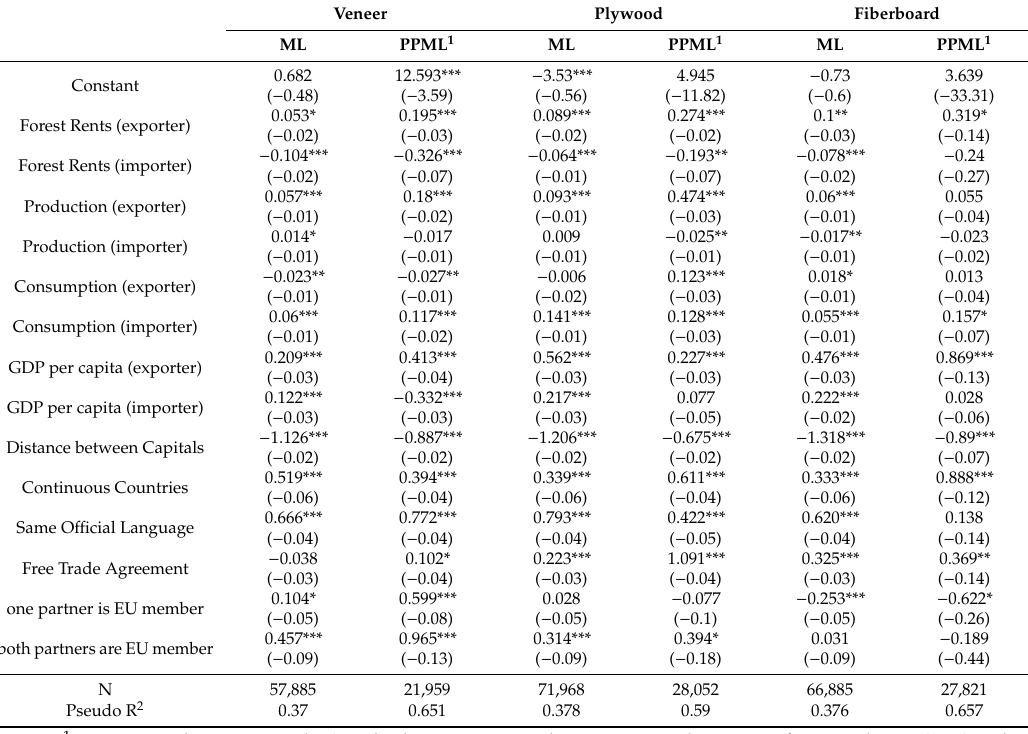
Table A4. Estimation results for the product group ‘veneer, plywood and fiberboard’.